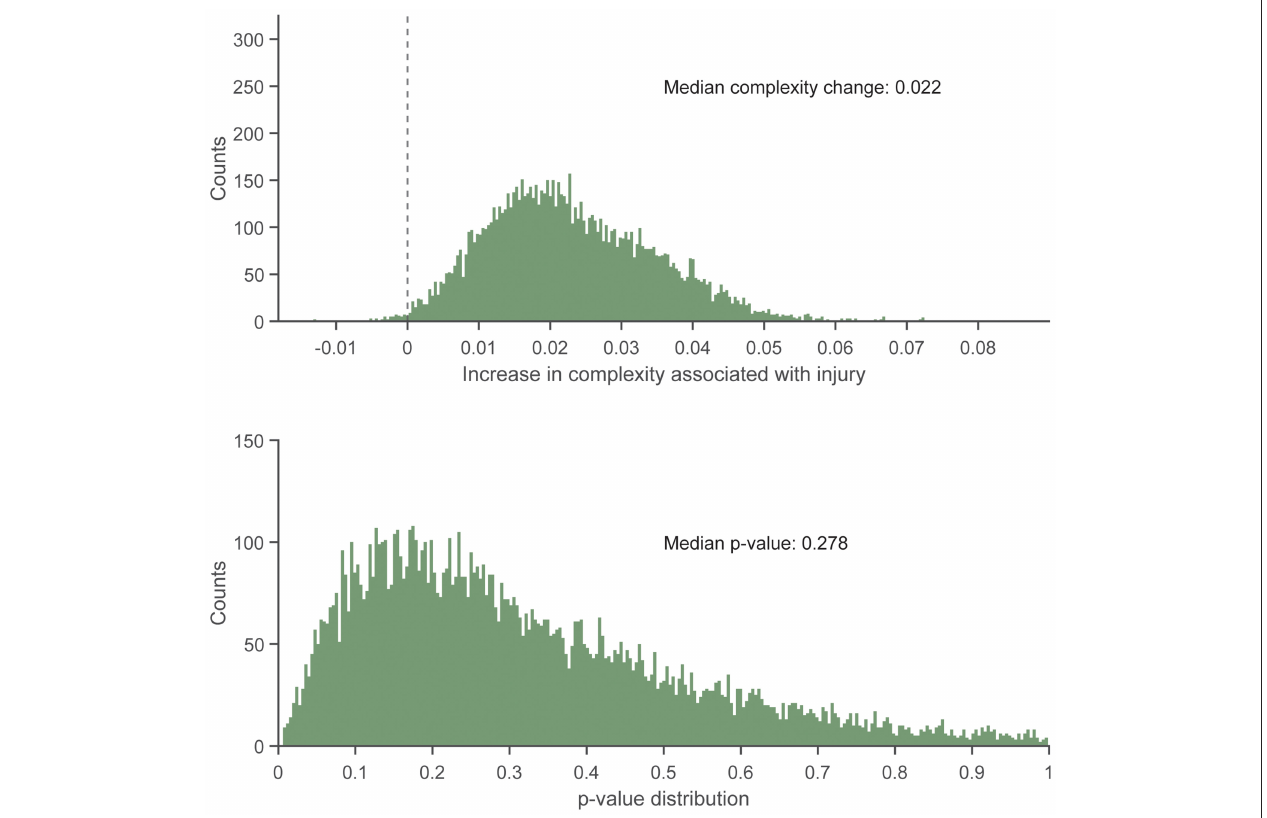
FIGURE 7 | Histogram showing the distribution of regression slopes (Top) and p -values (Bottom) for the increase in complexity in the injured group vs. the uninjured group at pre-injury, after adjusting for baseline complexity, across 10,000 replicates of the frequency-matching procedure. “Pre-injury” complexity was the last observed complexity value prior to reported injury in the injured group and the date-matched run of the control group resulting from the frequency matching procedure. The vertical dashed line in the top panel indicates the null hypothesis of no association (injured group increase in complexity vs. uninjured group = 0.0). That is, an effect > 0.0 is positive, indicating greater complexity in the injured group. 99.37% of iterations had effect estimates for the injured group of >